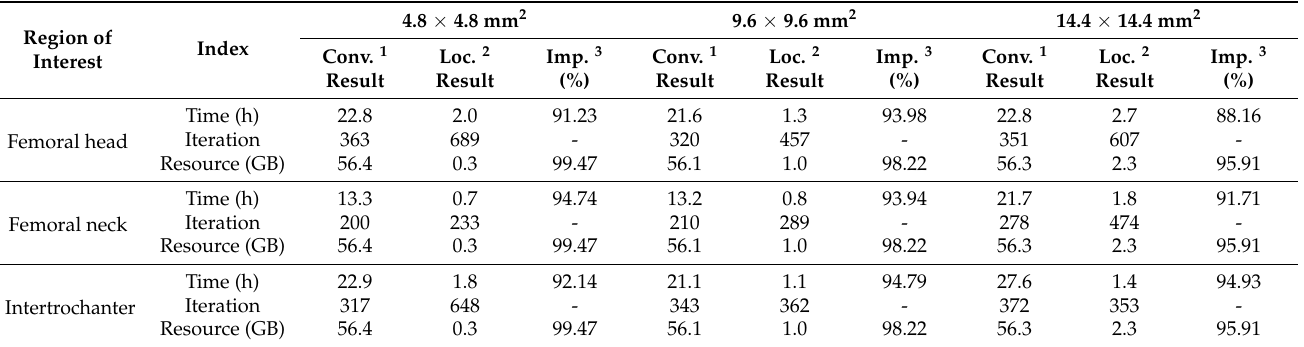
Table 1. Comparison of the total progress time and required computational resources between the conventional and localized